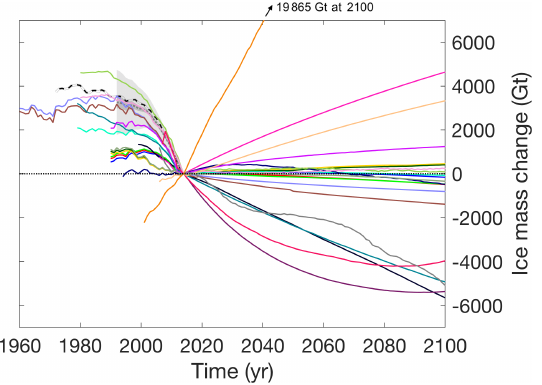
Figure 4. Ice mass change relative to the year 2014 for the histor- ical run and experiment ctrl_proj. The colour scheme is the same as in Fig. 3. Recent reconstructions of historical mass change (The IMBIE Team, 2019) are given as a dotted grey line with cumulated uncertainties assuming fully correlated and uncorrelated errors in light and dark shading, respectively. The dashed black-and-white line shows one specific reconstruction going back longer in time (Mouginot et al.,